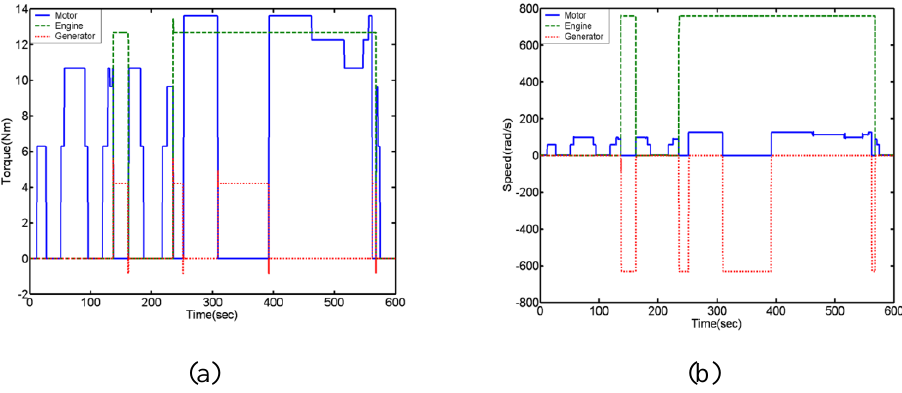
Figure 7. Output ( a ) torque, ( b ) rotational speed of motor, generator, and internal combustion